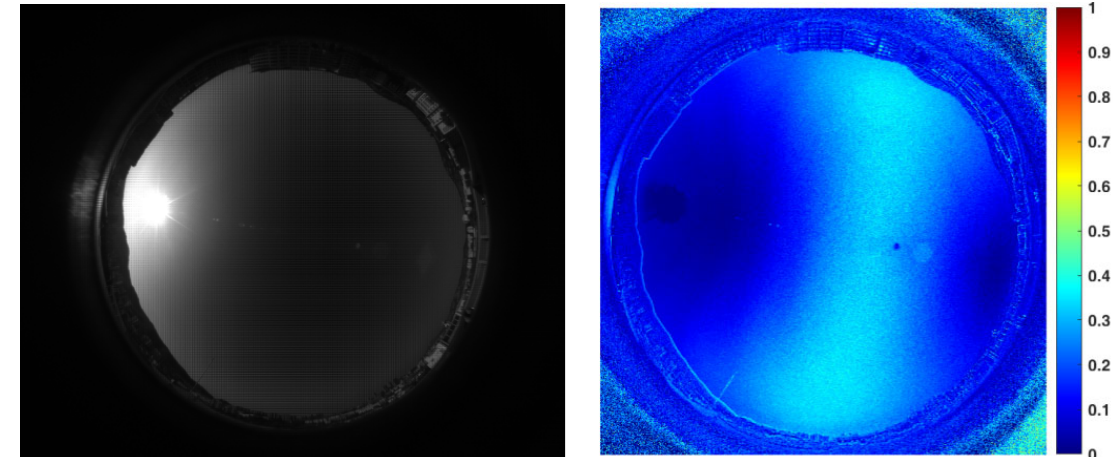
Figure 6. Underexposed sky image obtained by the polarization camera and the corresponding polarization distribution results.